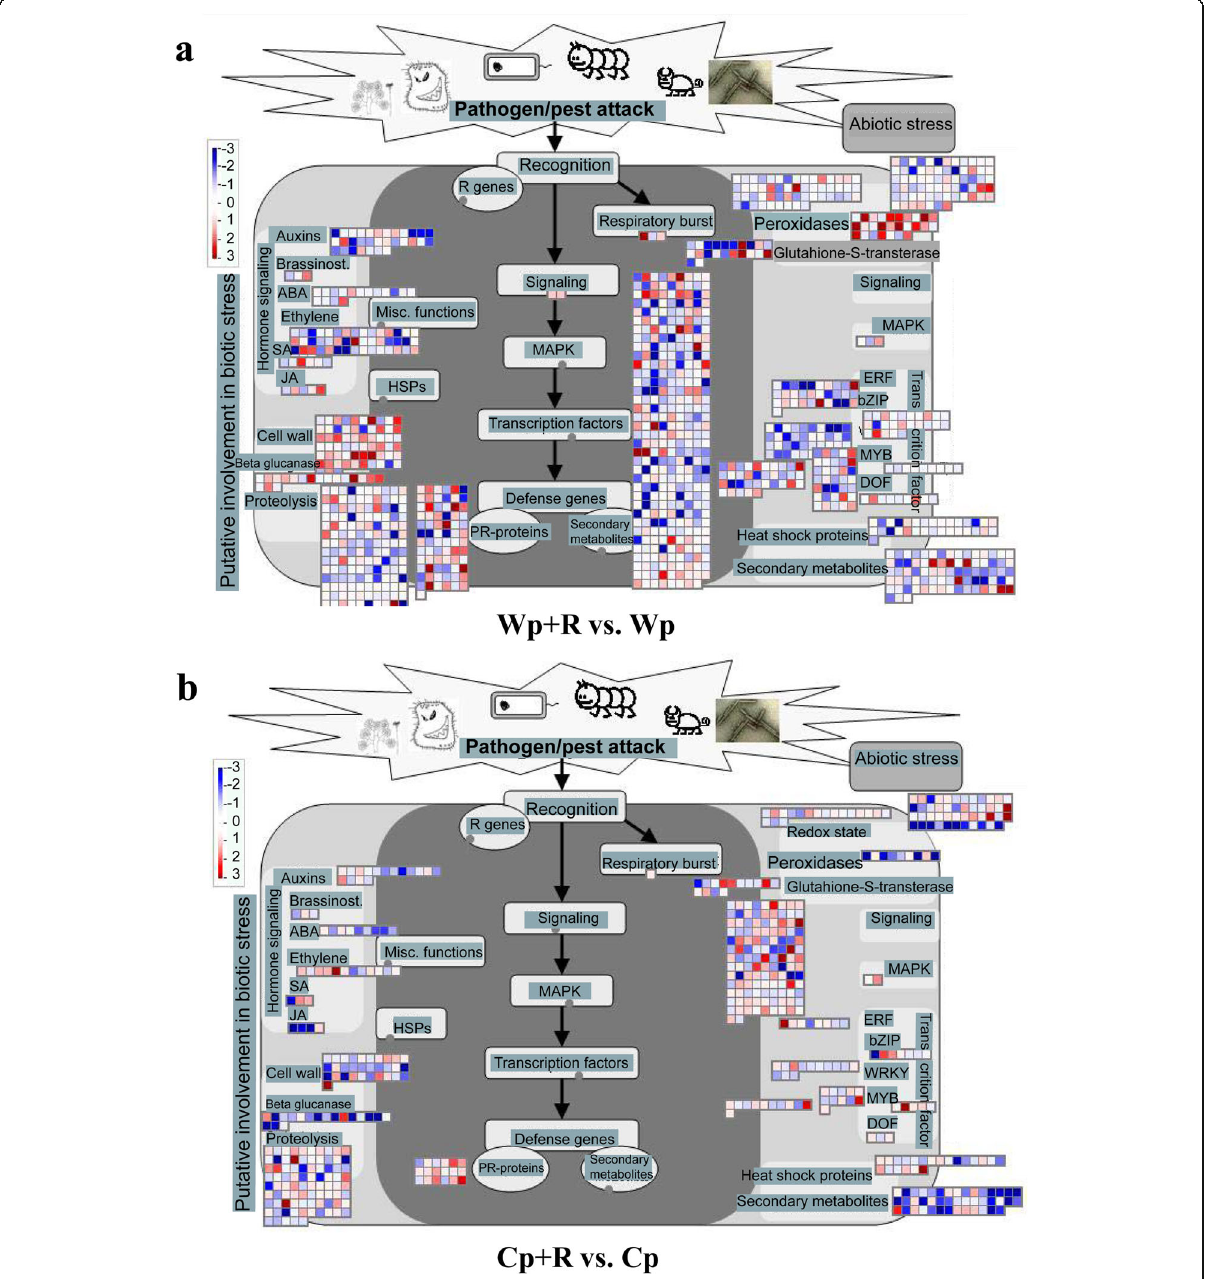
Fig. 6 Analysis of the biotic stress response of Rhizoglomus intraradices -inoculated plants to infection by Magnaporthe oryzae using MapMan 3.6.0. ‘ Wp+R vs. Wp ’ ( a ) and ‘ Cp+R vs. Cp ’ ( b ) comparisons. Cp + R, R. intraradices -inoculated cultivated rice infected with M. oryzae ; Cp, R. intraradices - uninoculated cultivated rice infected with M. oryzae ; Wp+R, R. intraradices -inoculated wild rice infected with M. oryzae ; Wp, R. intraradices -uninoculated wild rice infected with M. oryzae . Red color intensity indicates the levels of up-regulation by log 2 (fold-change)>0 and P value <0.05. Blue color intensity indicates the levels of down-regulation by log 2 (fold-change)<0 and P value